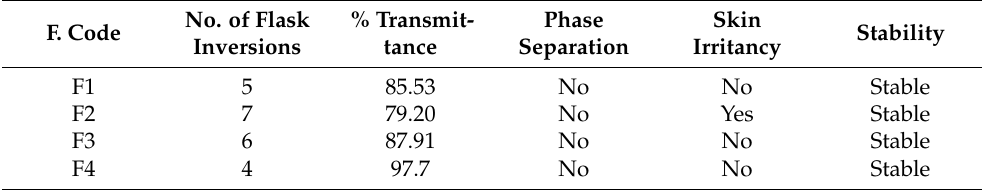
Table 3. Ease of emulsification, phase separation, skin irritation and stability of the emulsions. F.